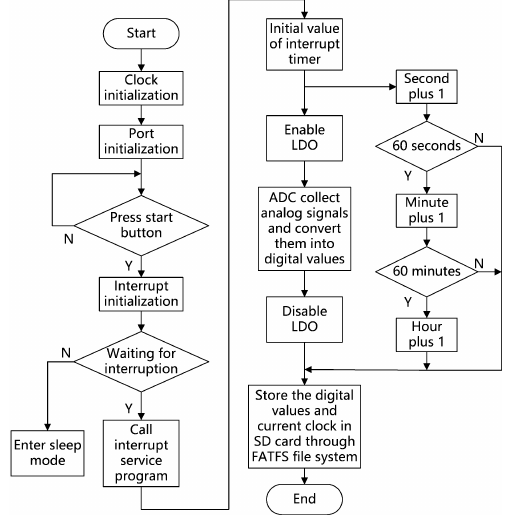
Figure 6. Program flow chart.